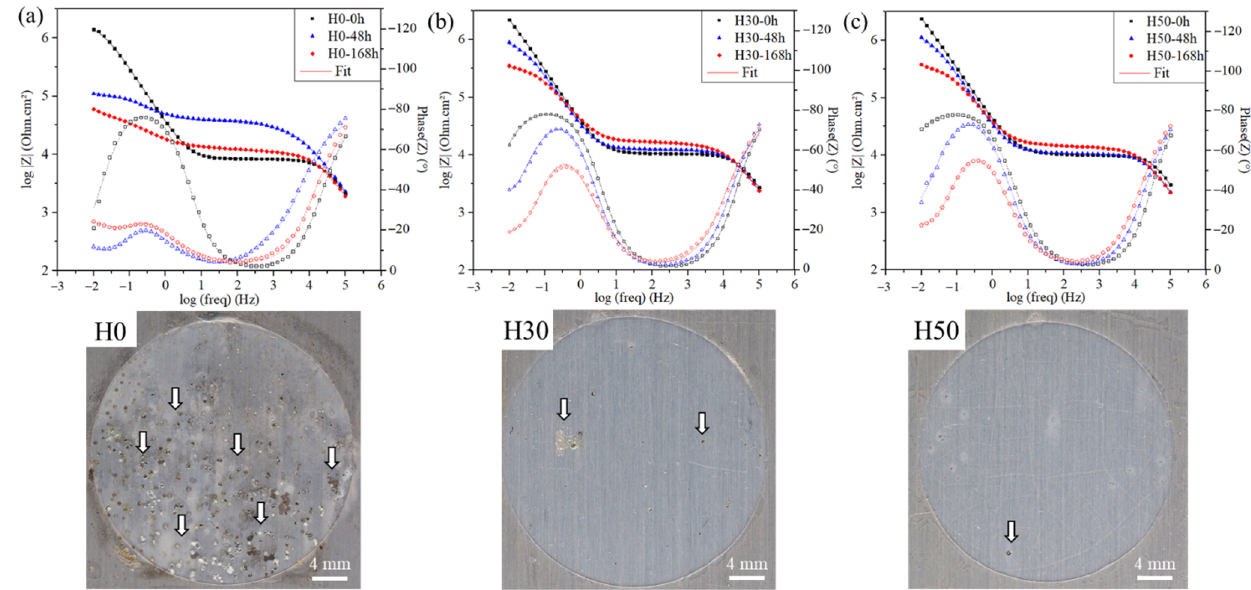
Figure 11. Electrochemical impedance spectroscopy (EIS) spectra after different immersion times in 0.05 M NaCl solution and photograph of the surface of samples after one week of immersion of ( a ) H0, ( b ) H30 and ( c ) H50 coatings, arrows show examples of corrosion pits.